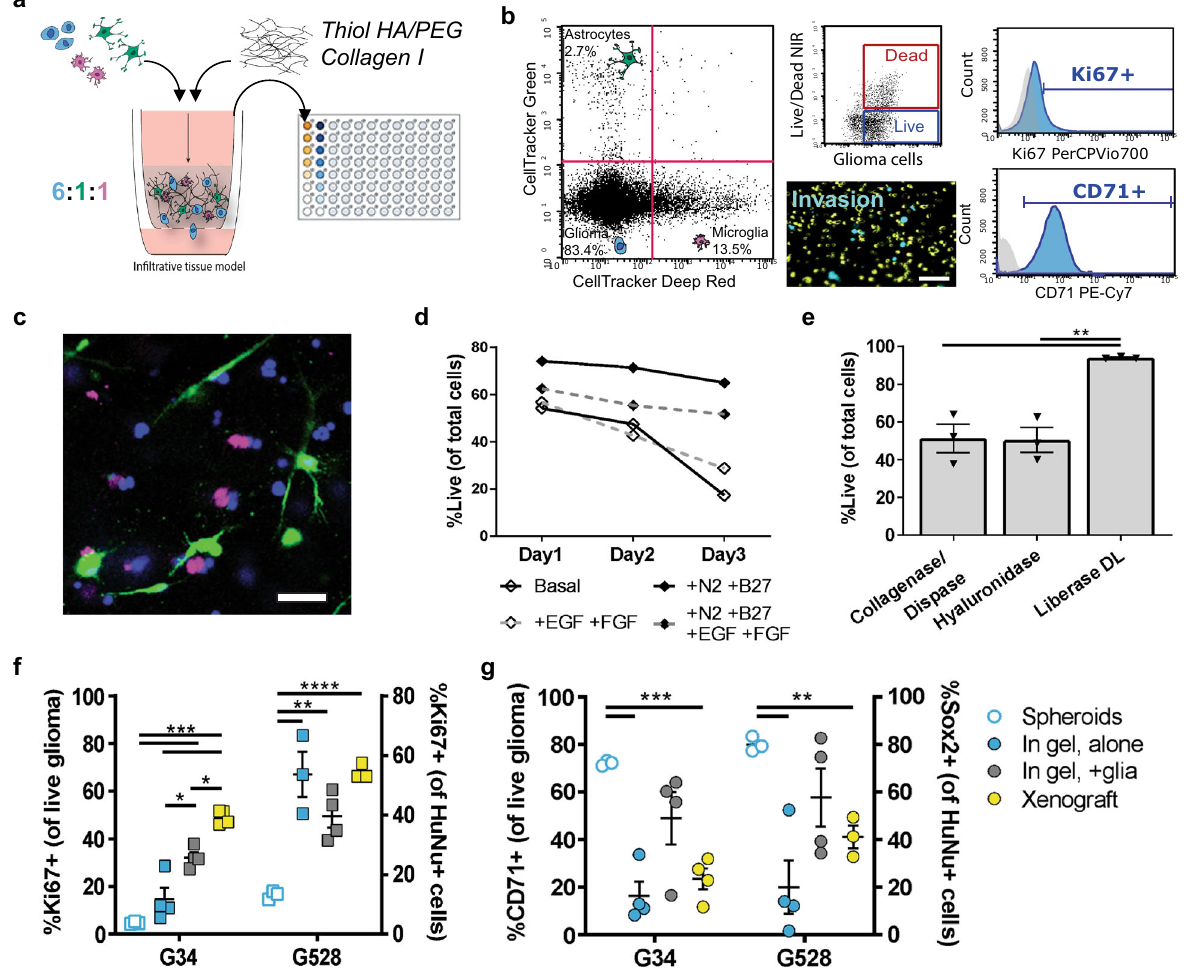
Fig. 2 Tunable model of the human invasive TME enables multiplexed analysis of glioma markers and comparison to in vivo marker expression. a Diagram of brain TME model setup using patient-derived GSCs, human astrocytes, and human microglia in a hyaluronan-based matrix and 96-well tissue culture insert format. b Representative fl ow cytometry plots showing the ability to distinguish astrocyte, microglia, and glioma cell populations and determine glioma-speci fi c proliferation (Ki67 + ), stemness (CD71 + ), and cell death. Isotype controls are shown in gray. Also shown is a representative fl uorescence image of the porous membrane for invasion quanti fi cation. Scale bar is 50 µm. c Representative fl uorescence image within the gel with glioma cells (blue), astrocytes (green), and microglia (magenta). Scale bar is 50 µm. d Quanti fi cation of cell viability under different media formulations for up to three days in hydrogel culture. e Quanti fi cation of cell viability following different enzymatic gel degradation protocols. f , g Comparison of %Ki67 + cells ( f ) and %CD71 + cells ( g ) for three in vitro cancer models and in vivo xenograft implants. In vitro data obtained by fl ow cytometry; in vivo data obtained from tissue sections, with the tumor border visually demarcated based on nuclear staining. Legends in f , g are the same. Comparisons conducted by unpaired t -tests, * p < 0.05 and ** p < 0.01 for n = 3 –